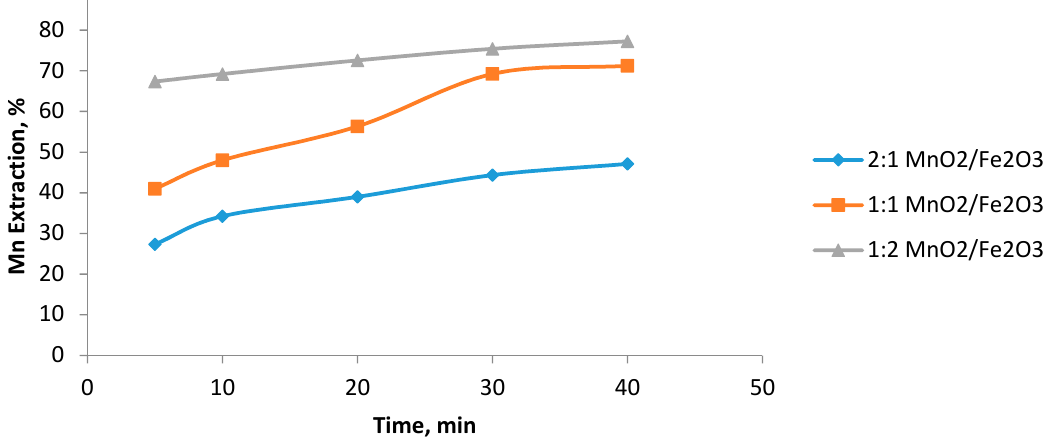
Figure 13. Effect of the MnO 2 /Fe 2 O 3 ratio on manganese extraction (25 °C, − 75 + 53 μ m, 1 mol/L H 2 SO 4 ).